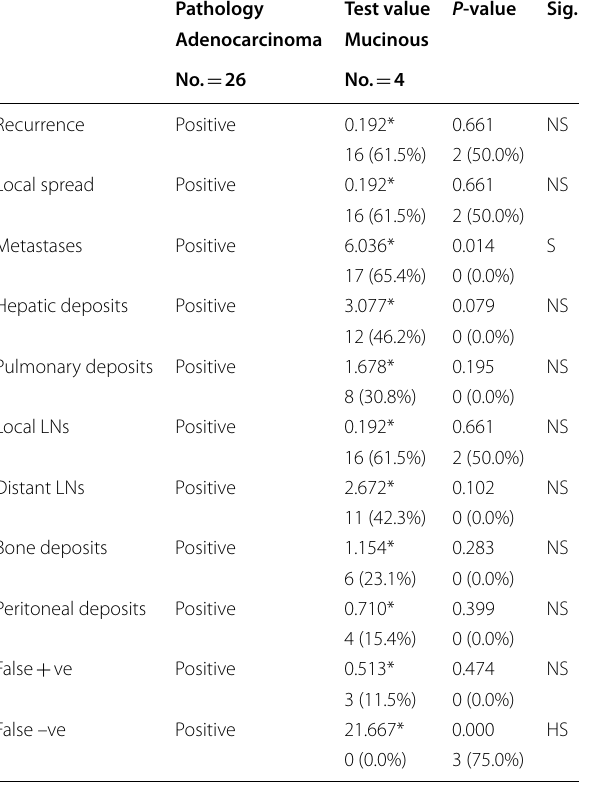
*Chi-square test